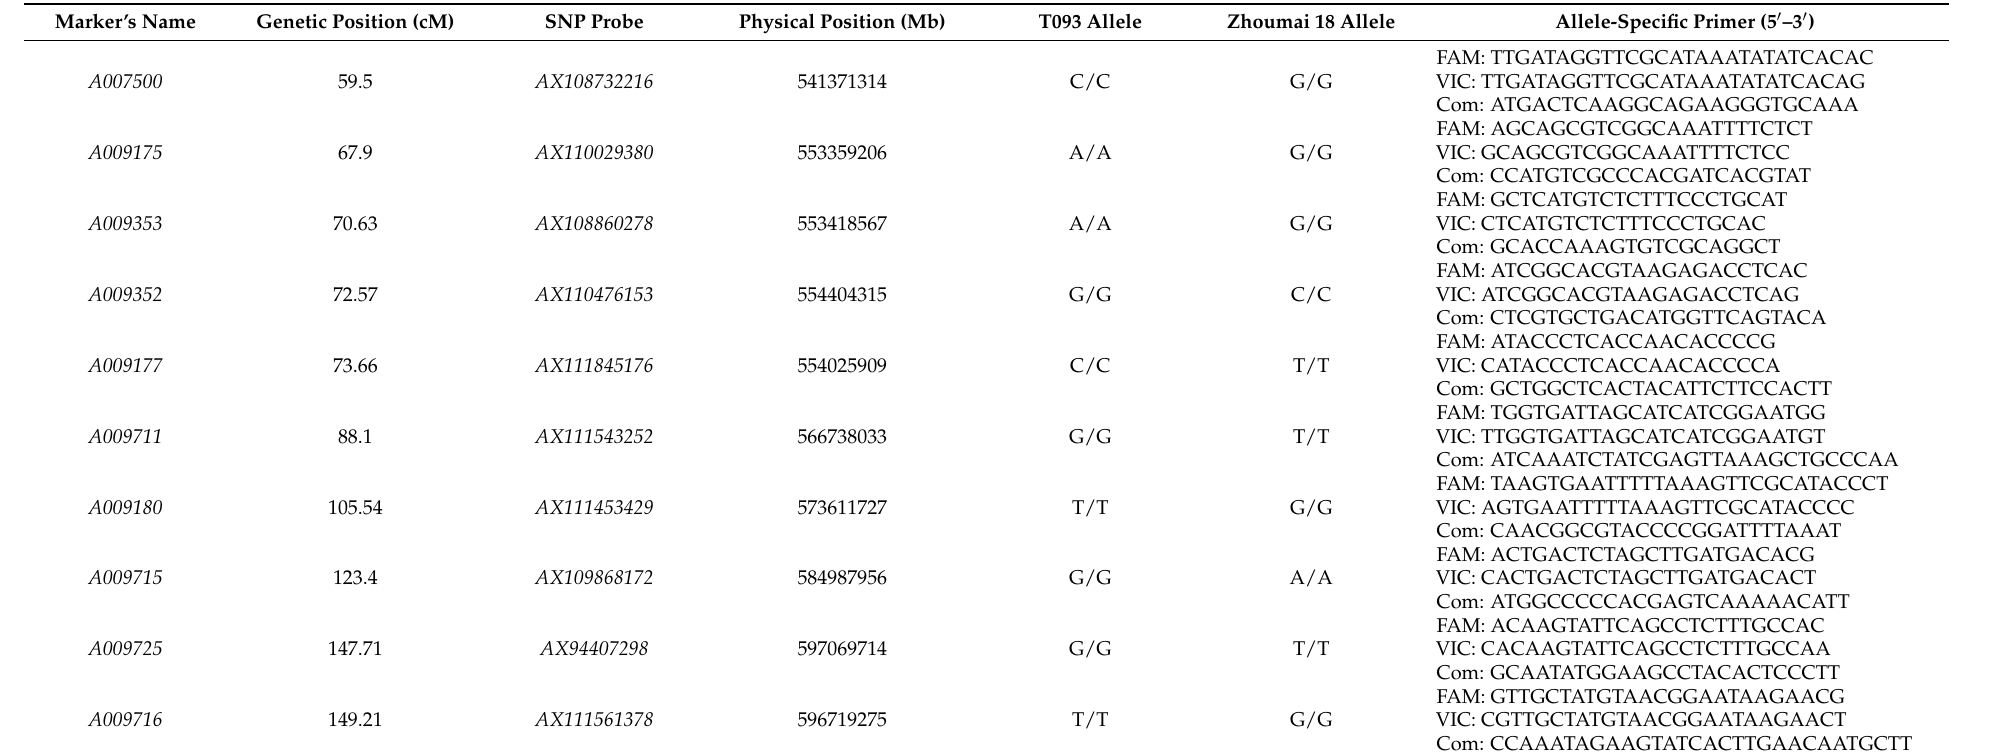
Table 3. Primer sequences of the Kompetitive allele-specific PCR (KASP) assays developed in this